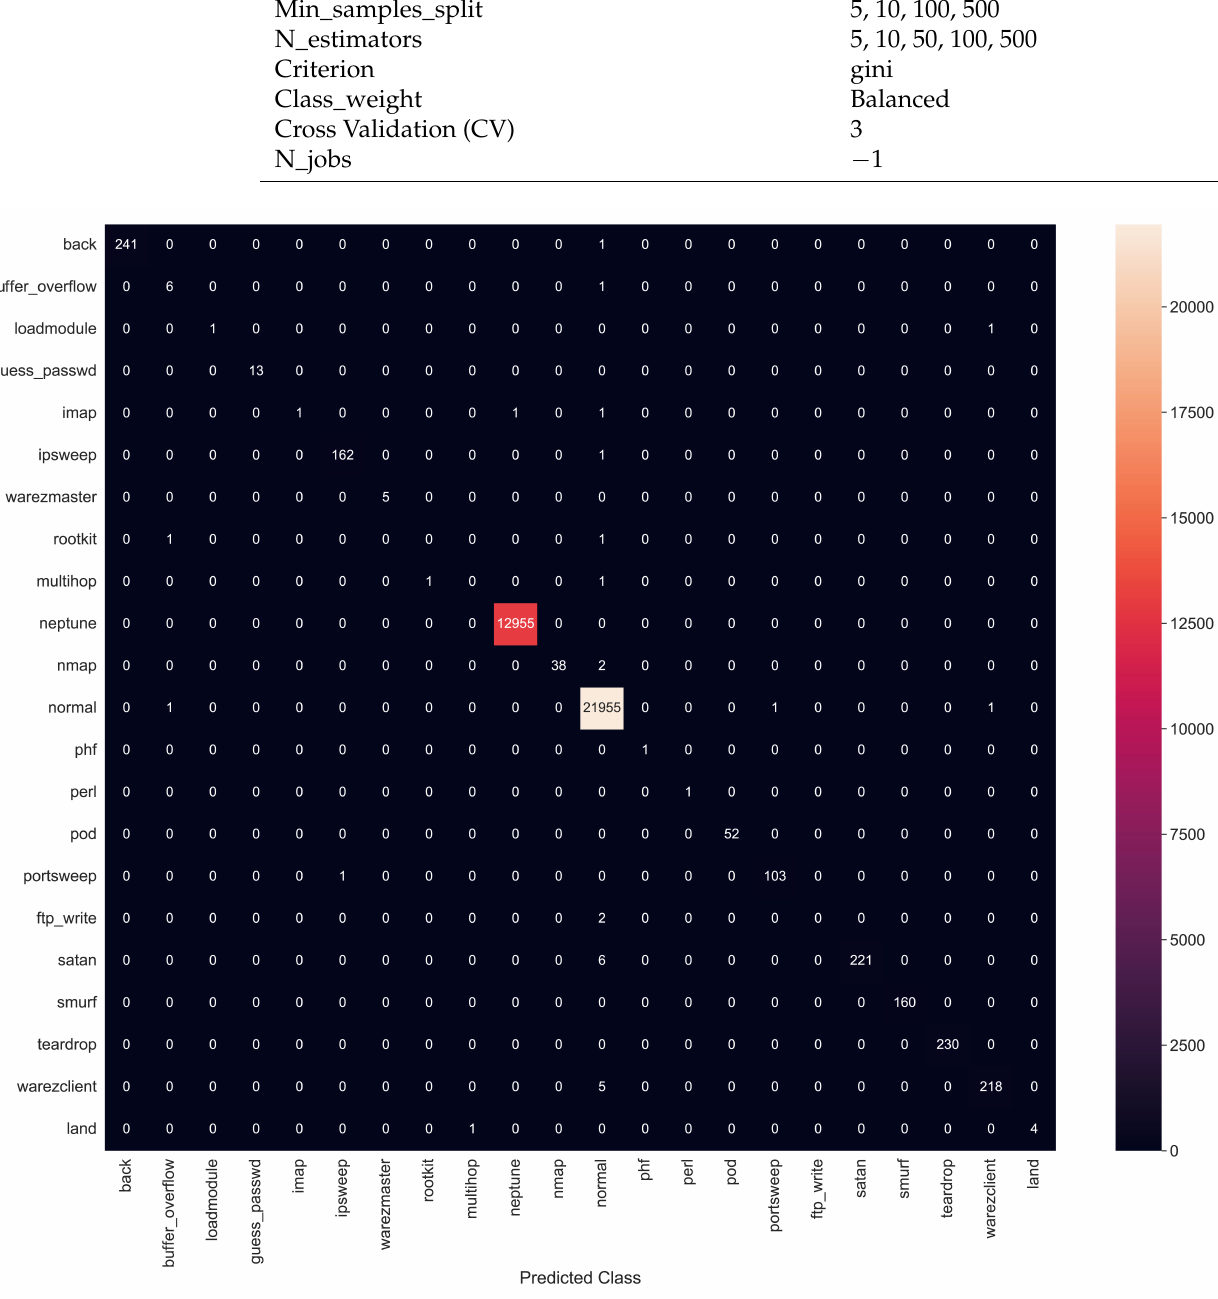
Figure 11. Confusion matrix for Random